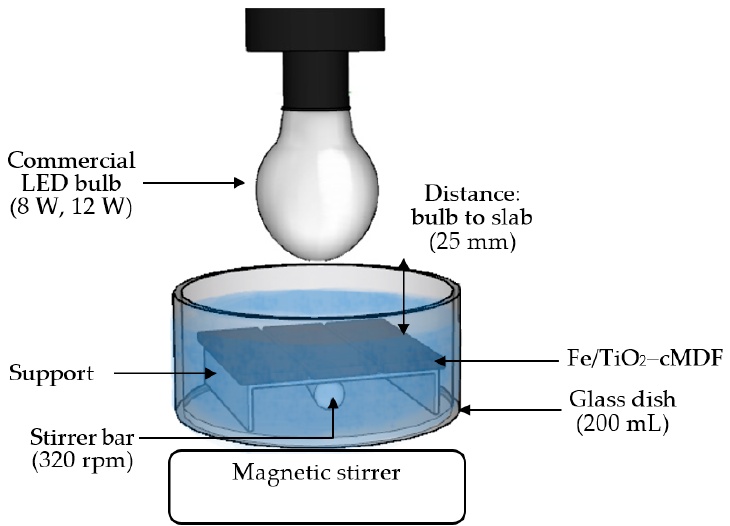
Figure 4. Representation of the photodegradation experiment under commercial LED